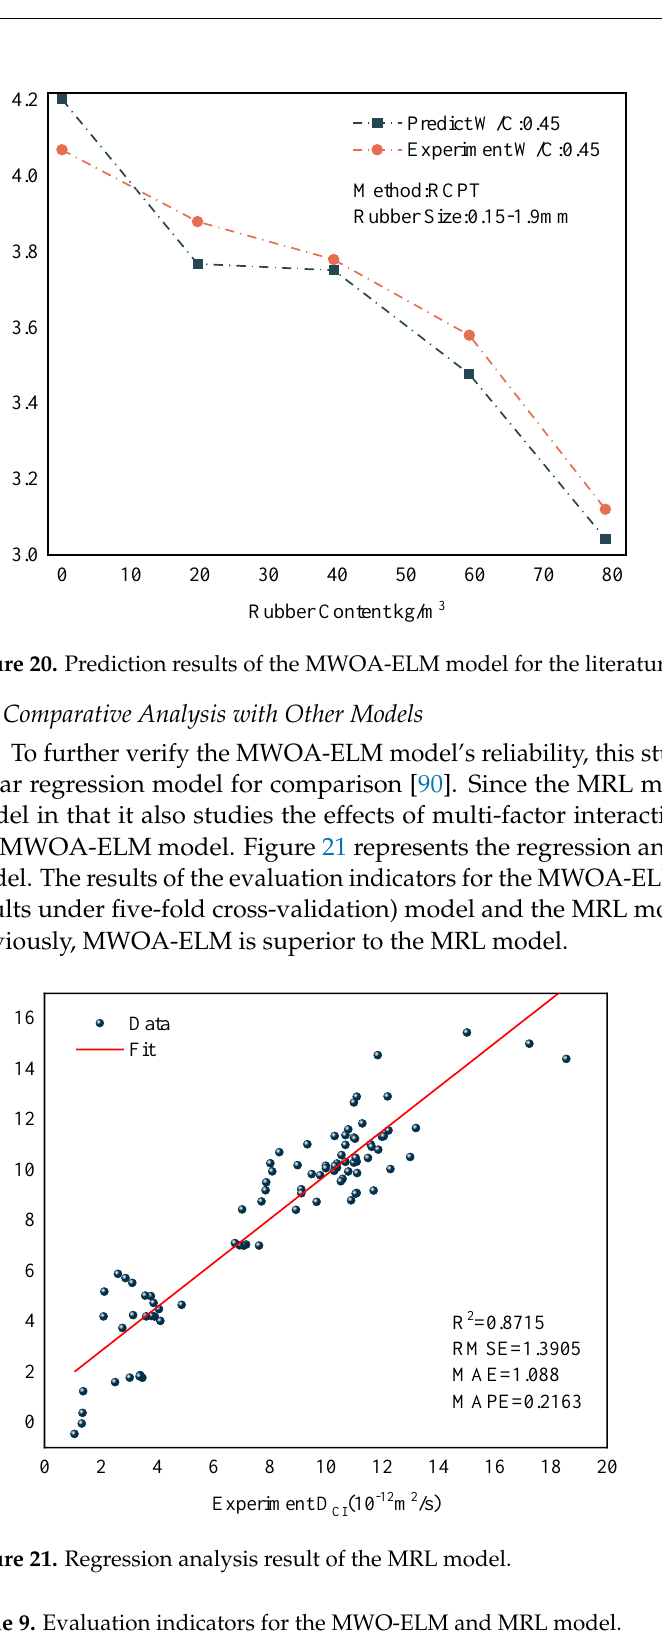
Figure 19. Prediction results of the MWOA-ELM model for the literature [56].